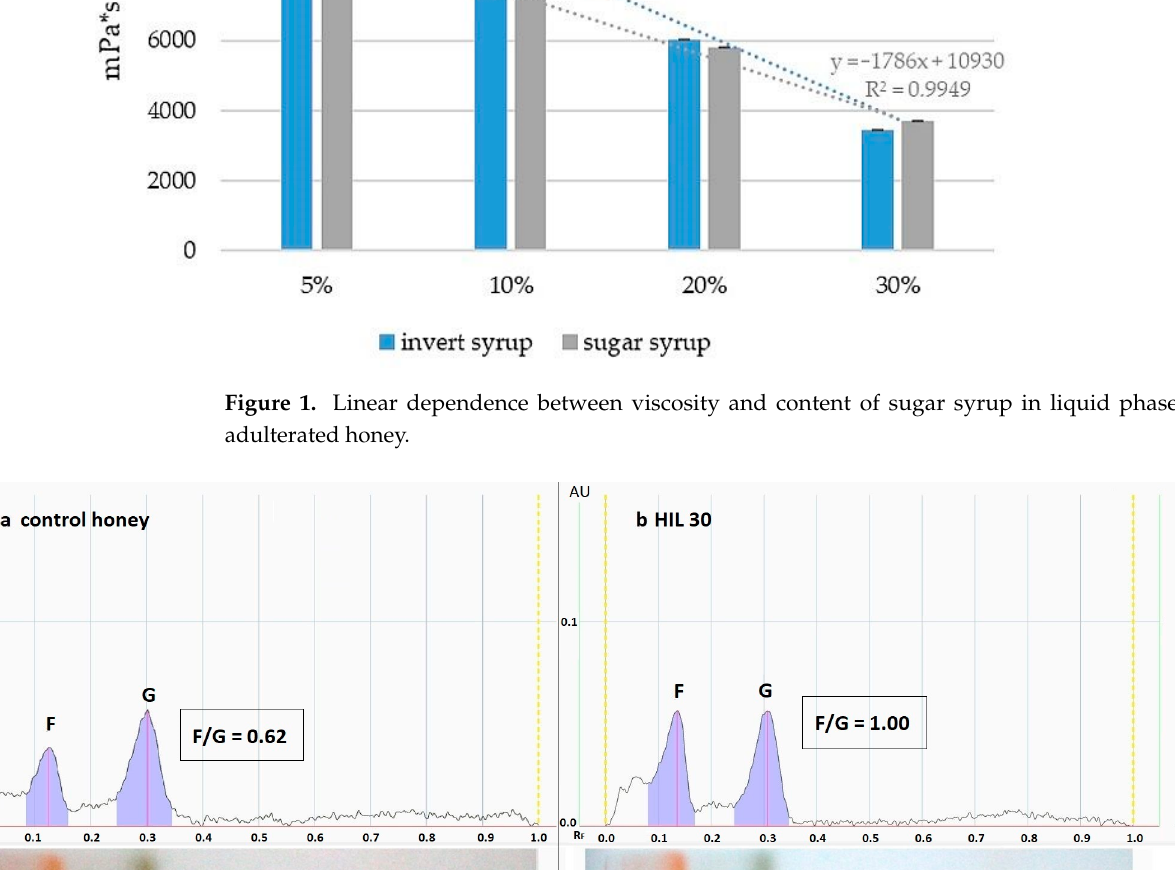
Figure 1. Linear dependence between viscosity and content of sugar syrup in liquid phase of adul- terated honey.